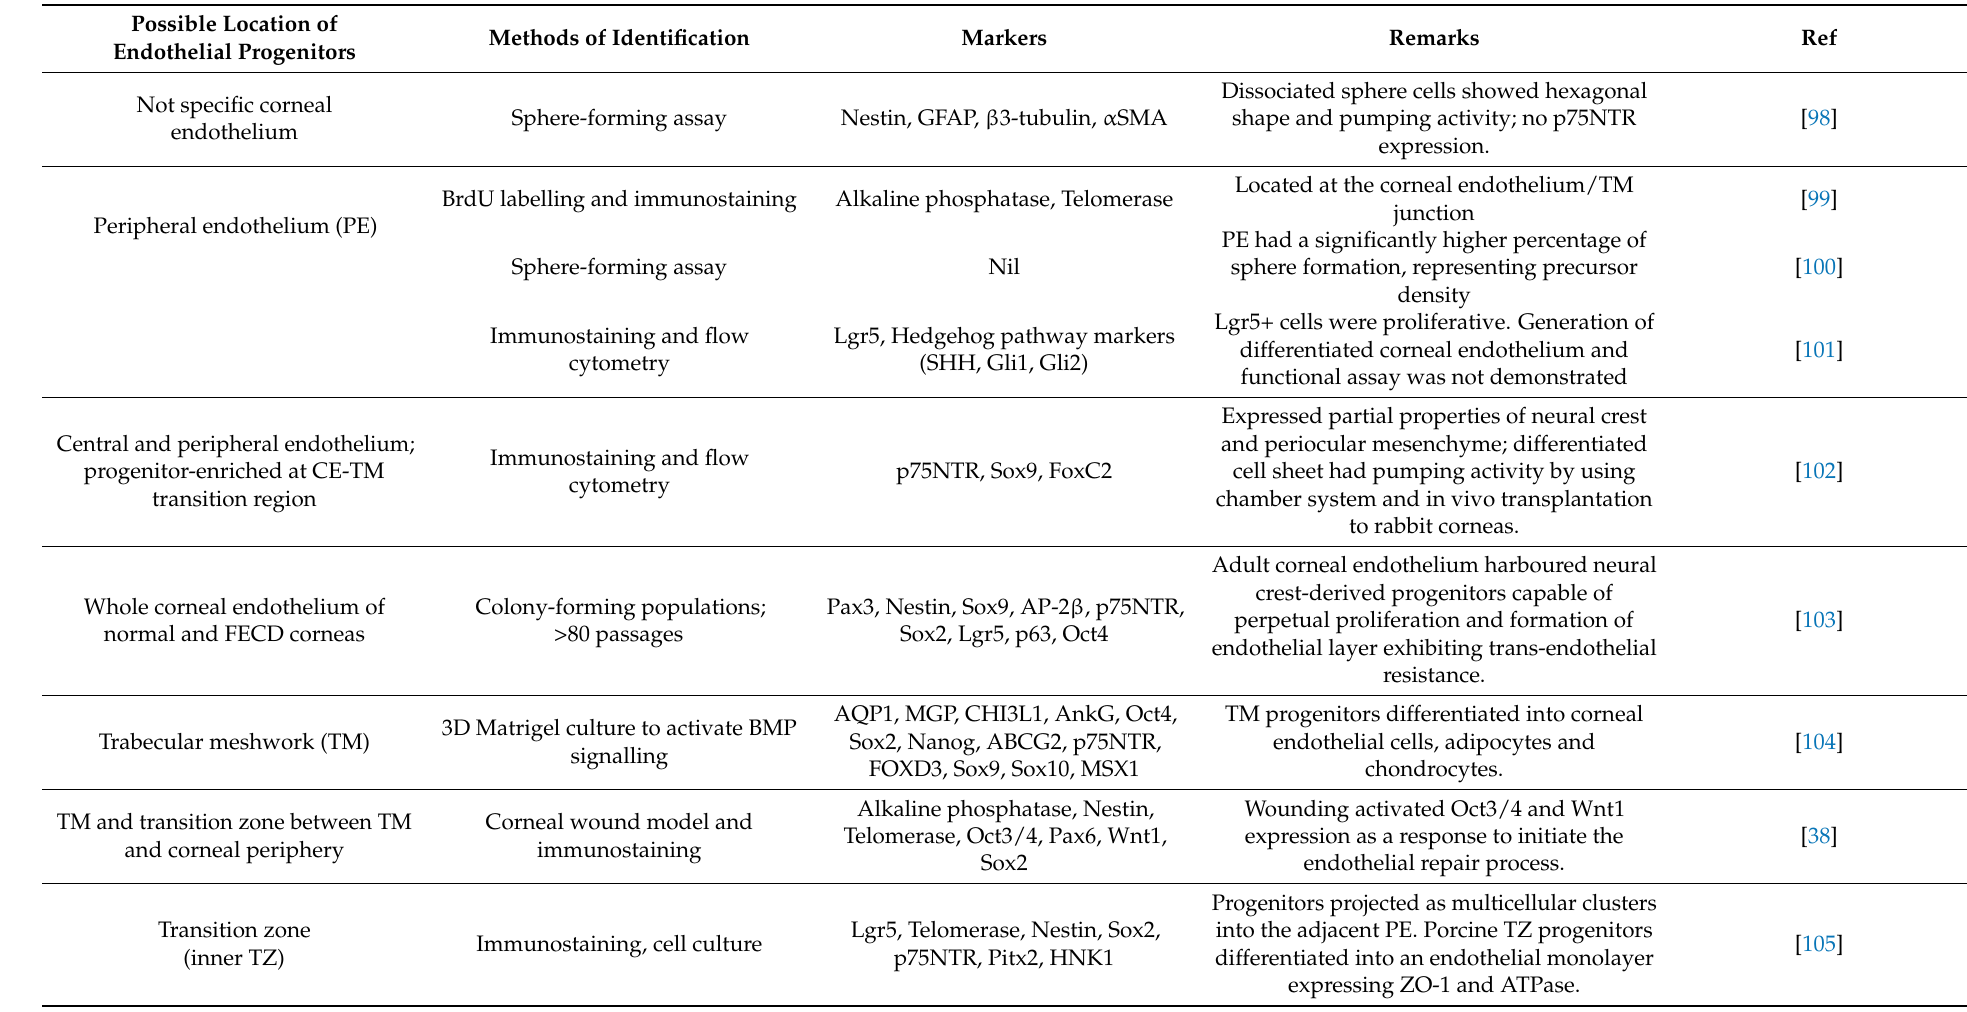
Table 4. Studies reporting human corneal endothelial progenitors with potential location, identification and differentiated functions. Reprinted with permission from Sie et al. (2020)